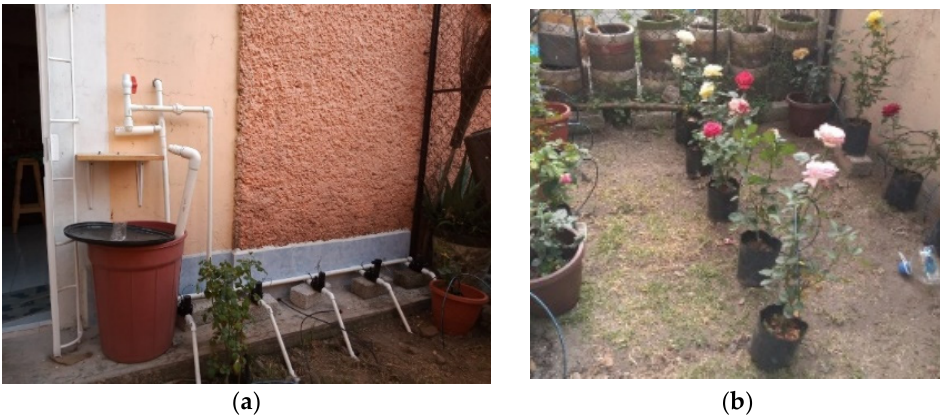
Figure 11. Implementation of an irrigation system: ( a ) Micro sprinkler irrigation system for a M [5 × 3] rose matrix module with 5 rows; ( b ) matrix module columns of the roses’ distribution.